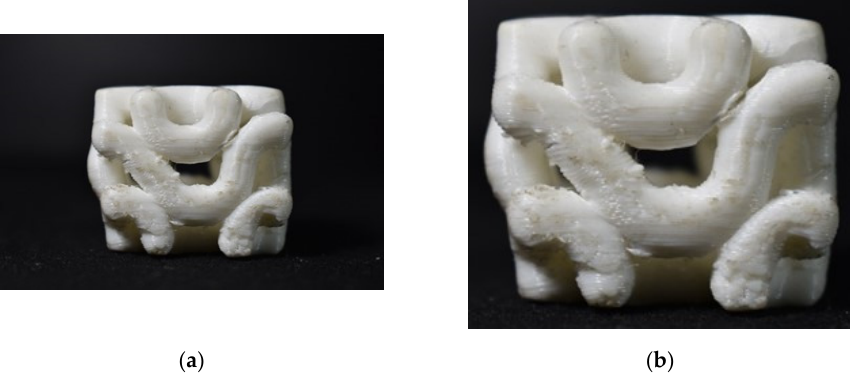
Figure 19. ( a ) A 3D printed AGM; ( b ) Tested model with failed structure.